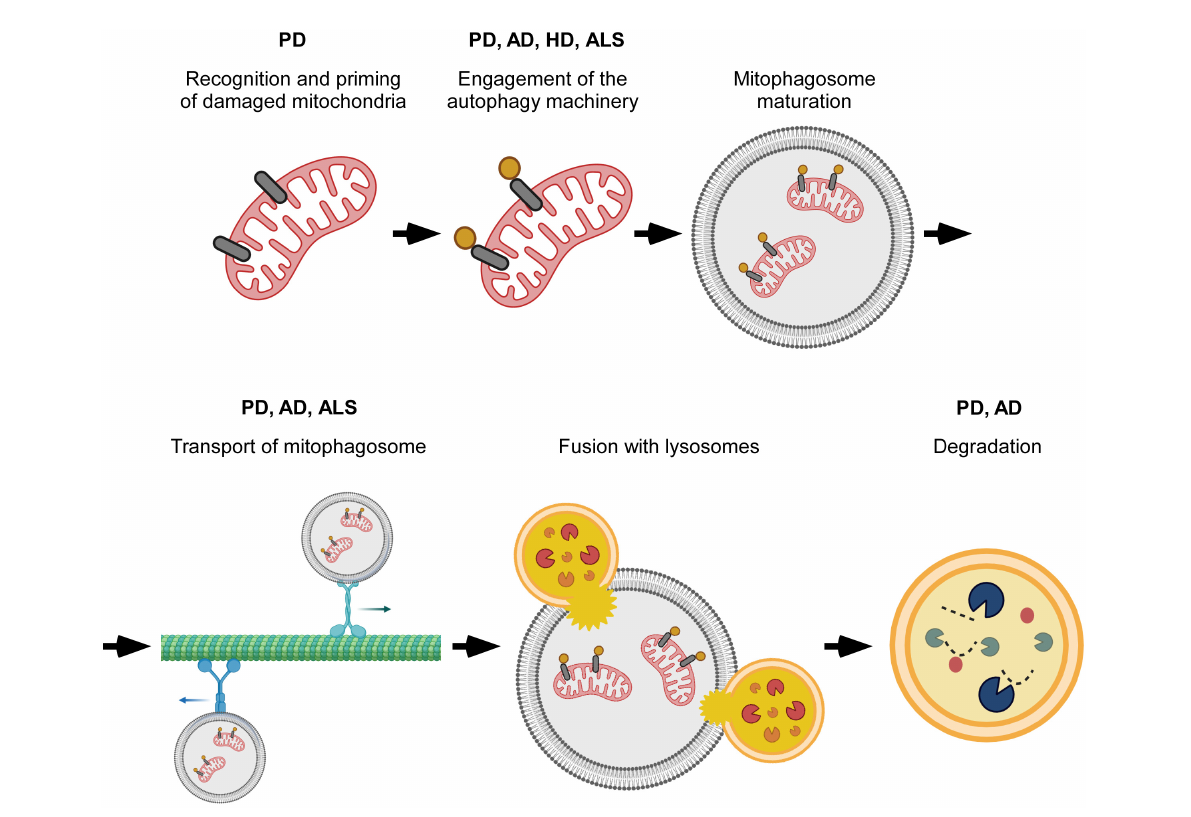
FIGURE2 Overview of specific steps in mitophagy that are perturbed in neurodegenerative disease. Mitophagy progression is altered at different stages of the process. Disruptions occur during the initial recognition of damaged mitochondria, formation and transport of mitophagosomes, and degradation of mitochondria by lysosomes. The particular point(s) of mitophagy defect vary with neurodegenerative disease, and, possibly with, disease subtype. Created with